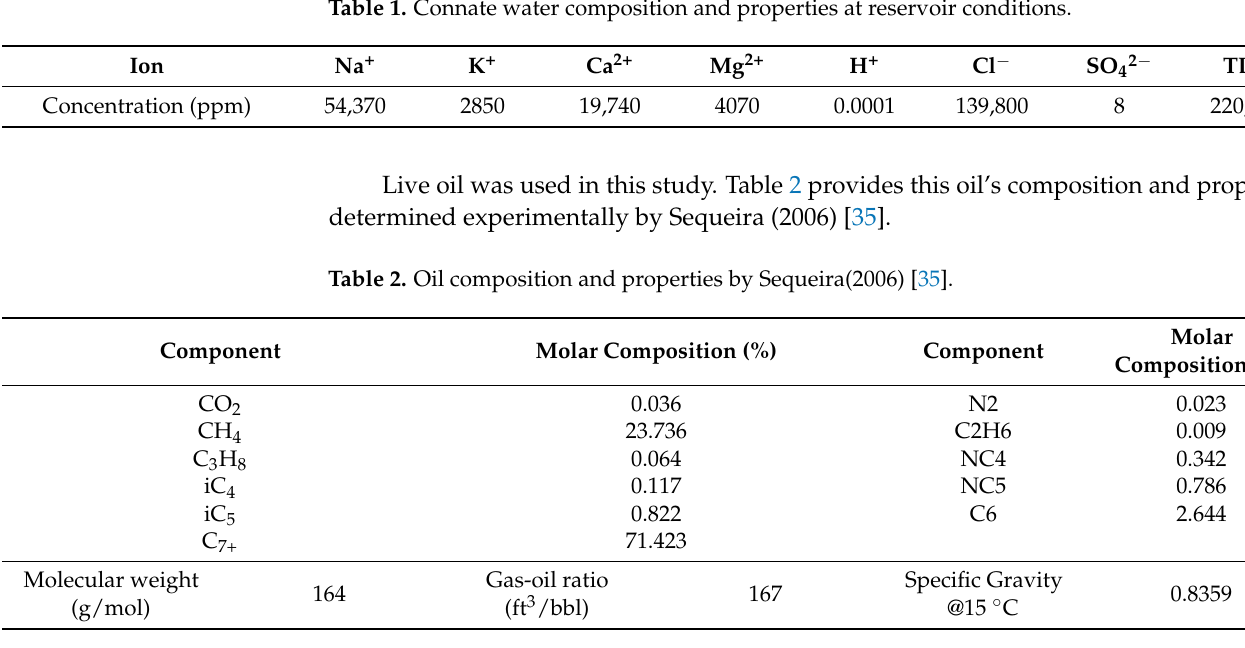
Table 1. Connate water composition and properties at reservoir conditions.